Question: Sum up the contents of this chart in one sentence.
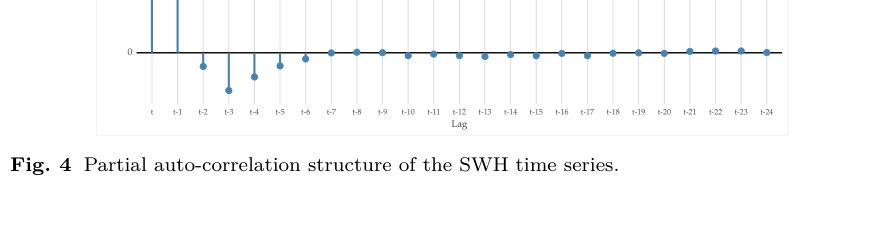
Answer: Partial auto-correlation structure of the SWH time series.